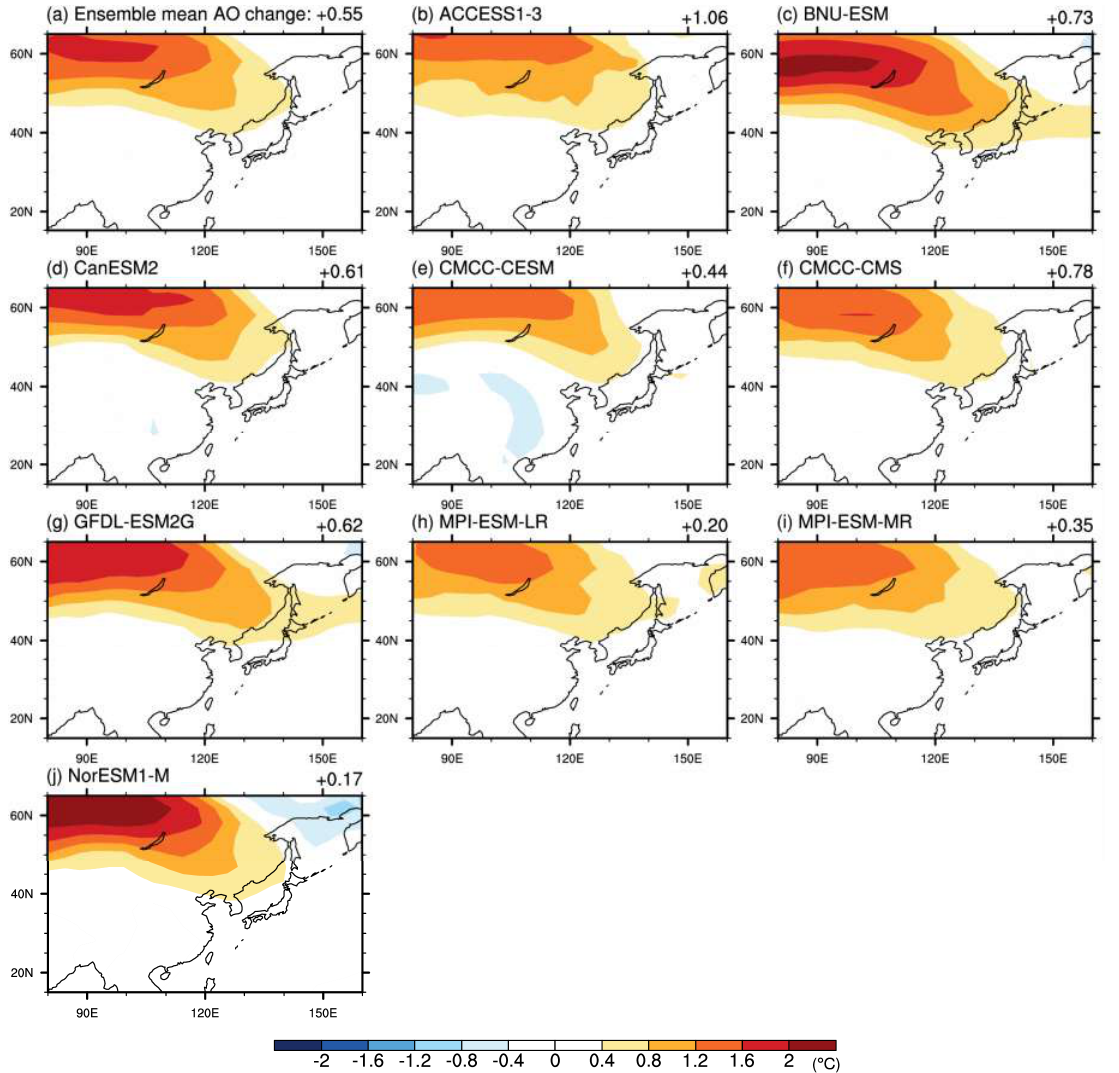
Figure 11. Regression coefficient maps for SAT anomalies based on the AO index for 1975–2005. The values in the top-right of each panel show the projection values between the AO pattern and changes in the mean SLP between 2065–2095 and 1975–2005 from nine CGCMs and their ensemble mean.